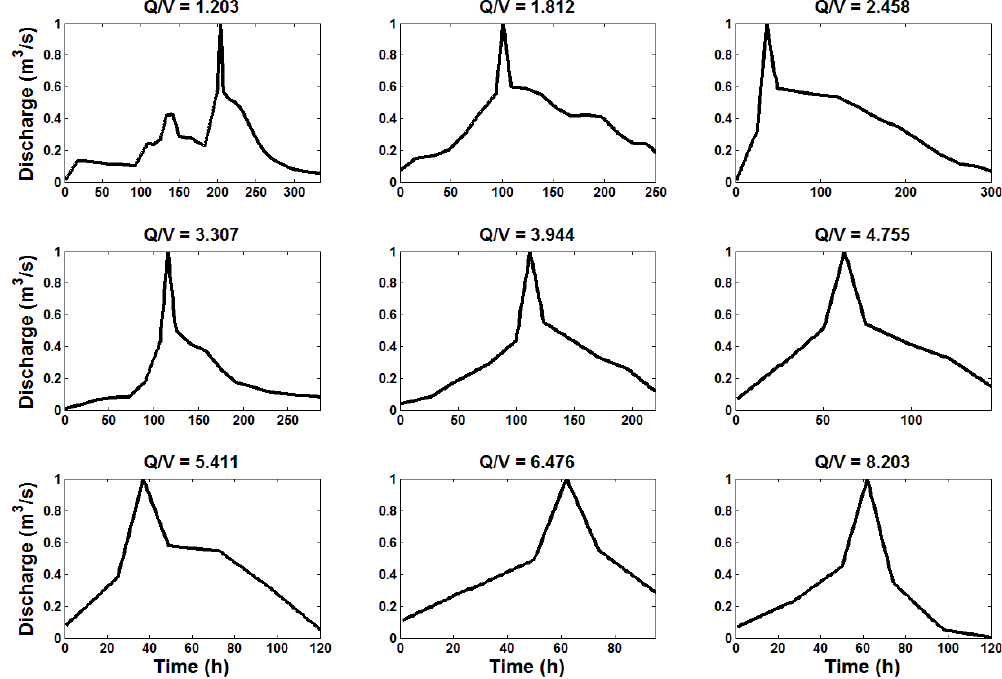
Fig. 6. Examples of the ratio between the peak and volume for different hydrograph